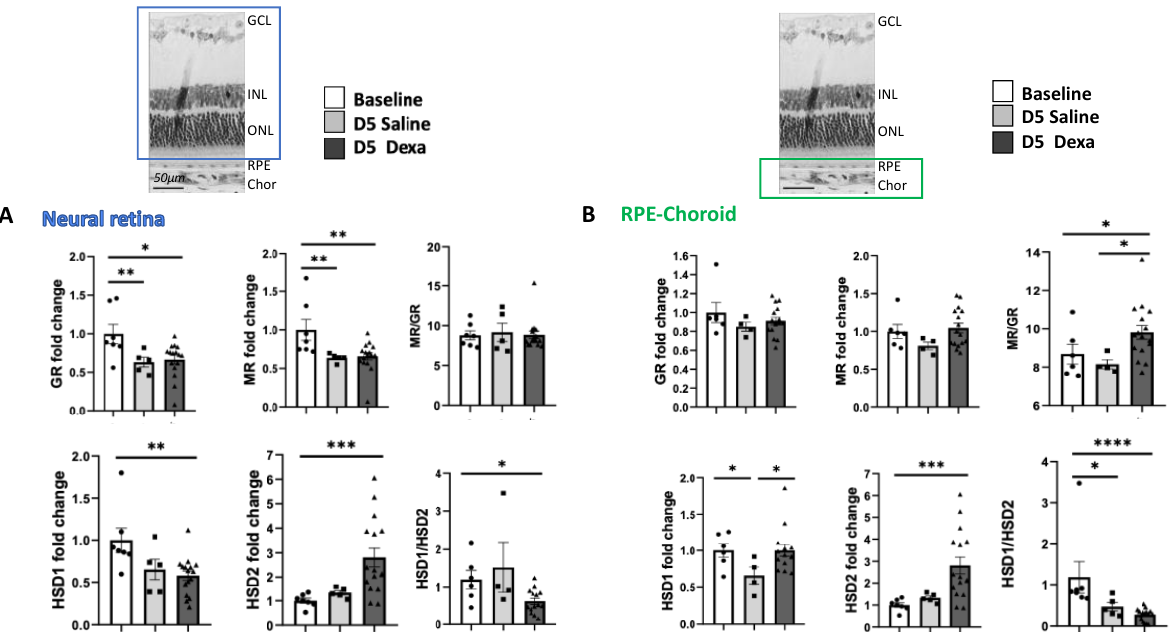
Figure 2. Corticoid receptors and hydroxysteroid dehydrogenase gene expression in the retina and RPE/choroid. ( A ) neural retina: Nr3c1 , encoding GR, Nr3c2 encoding MR and 11 β -hsd1 and 2 expression at baseline ( n = 7), after 5 days of daily injection of dexamethasone ( n = 16), or saline ( n = 6); ( B ) RPE/choroid: Nr3c1 , encoding GR, Nr3c2 encoding MR and 11 β -hsd1 (HSD1 ) and 2 (HSD2) expression at baseline ( n = 7), after 5 days of daily injection of dexamethasone ( n = 16), or saline ( n = 6), * p < 0.05, ** p < 0.01, *** p < 0.001, **** p < 0.0001.